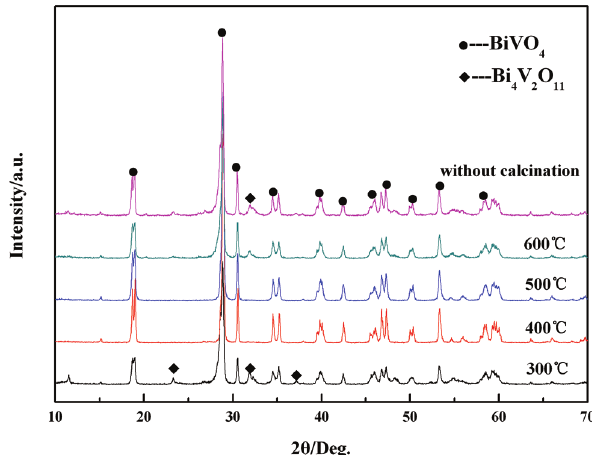
Figure 1: XRD patterns of BiVO 4 with different heat treatment temperatures for 1